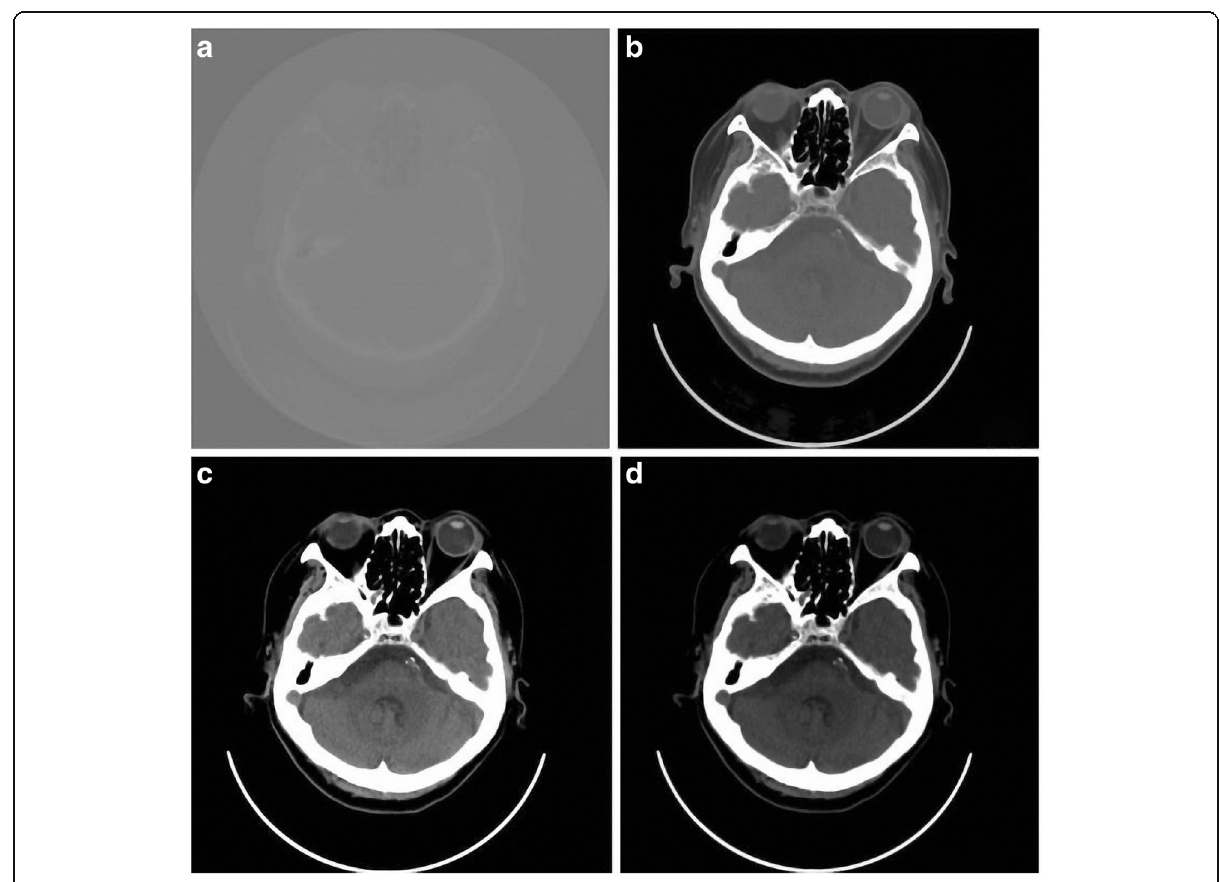
Fig. 5 The result image of window width and window position